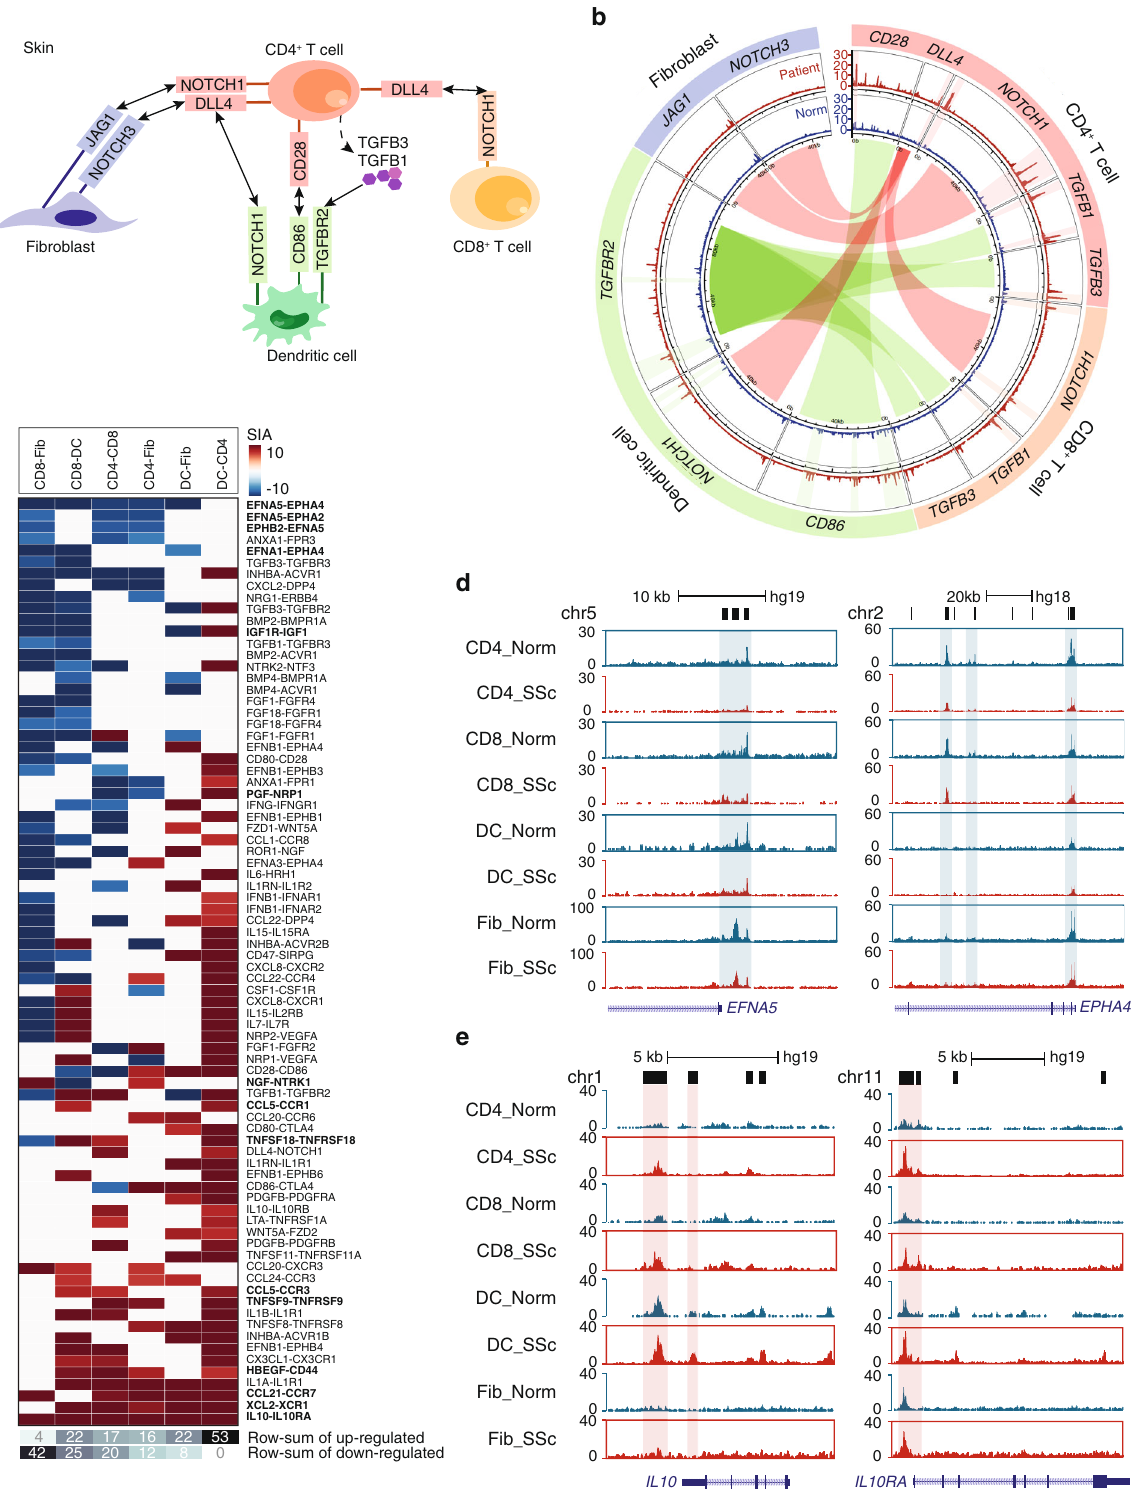
signaling pathways (Fig. 6e), whose dysregulation may increase risk for many autoimmune diseases 42,43 , yet the epigenetic mechanism of these pathways driving the autoimmunity and tissue fi brosis has yet been fully uncovered. Several novel growth factors and chemokine pathways were also evinced by our analysis, such as the downregulation of IGF1R/IGF1 and PGF/NRP1 and upregulation of HBEGF/CD44, XCL2/XCR1 NATURE COMMUNICATIONS| (2020) 11:5843